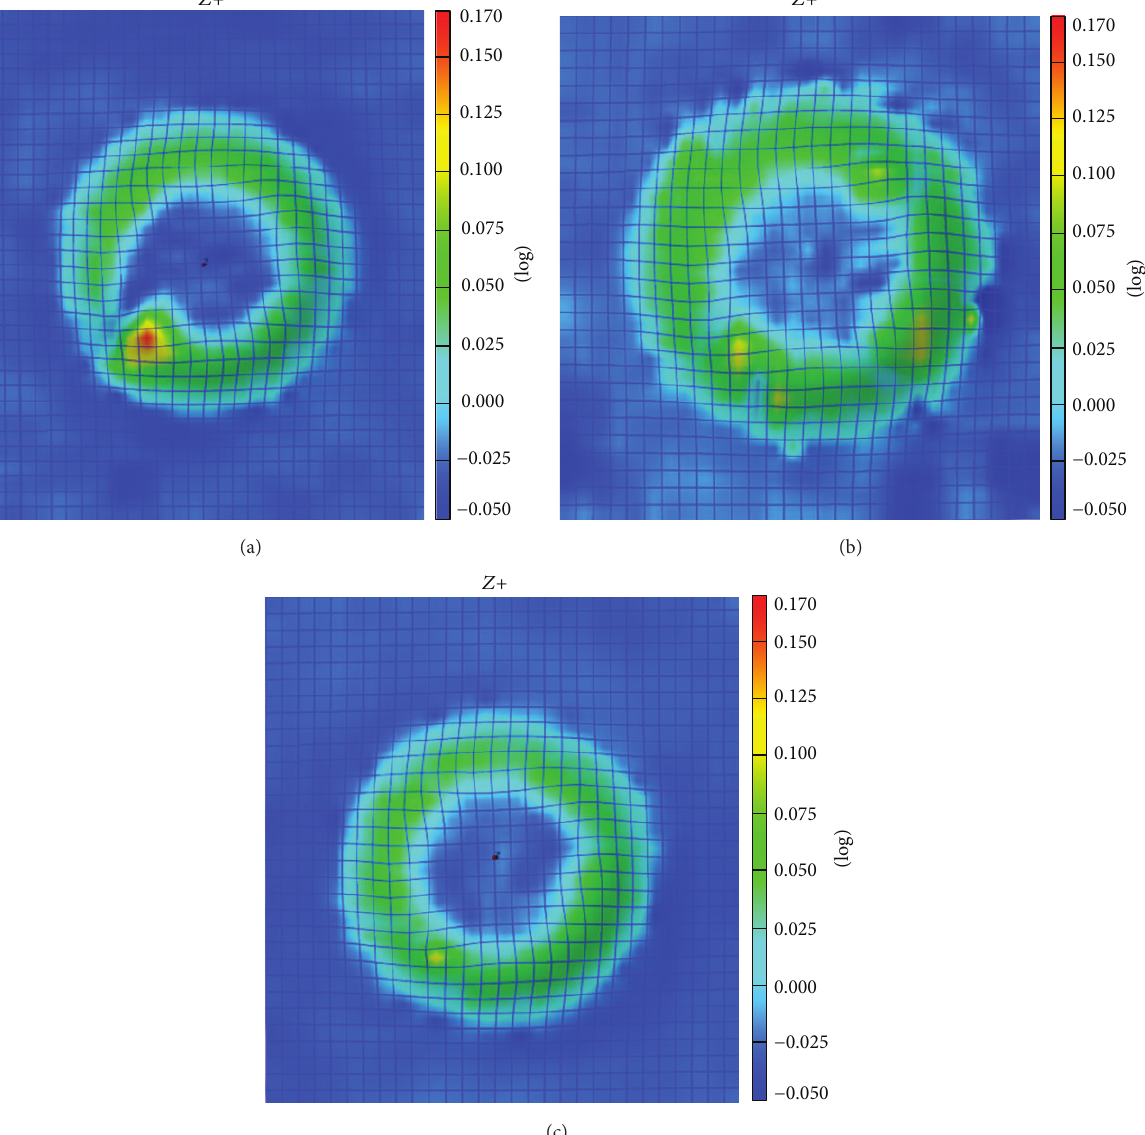
Figure 5: The minor strain variation for the specified three different